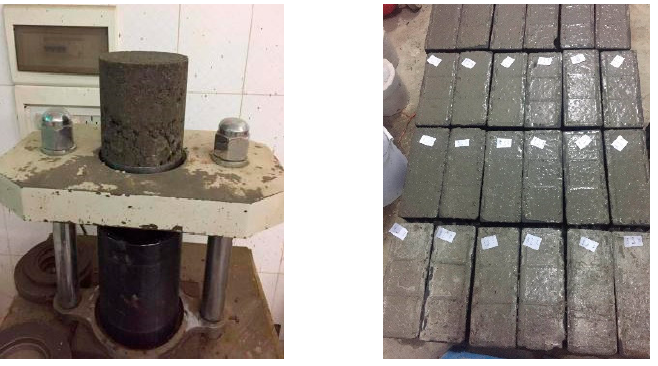
Figure 5. Specimen preparation and curing.